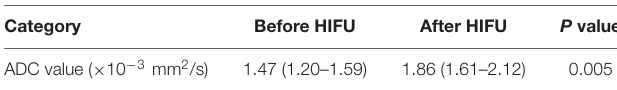
TABLE 5 | Comparison of ADC values before and after HIFU